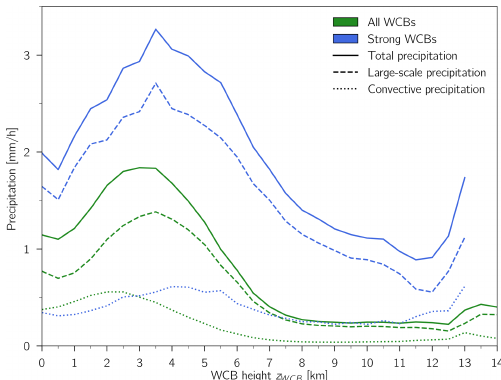
Figure 7. ERA5-based total (solid), large-scale (long-dashed) and convective (short-dashed) surface precipitation accumulated dur- ing the previous hour, averaged over all (green) and strong WCBs (blue), separately for different height bins of the matching WCB air